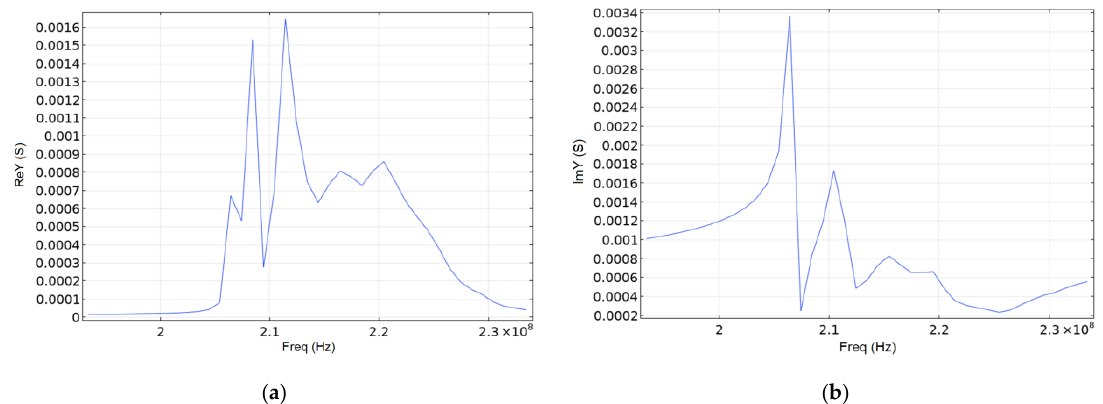
Figure 8. Real ( a ) and imaginary ( b ) admittance component for LiNbO 3 .